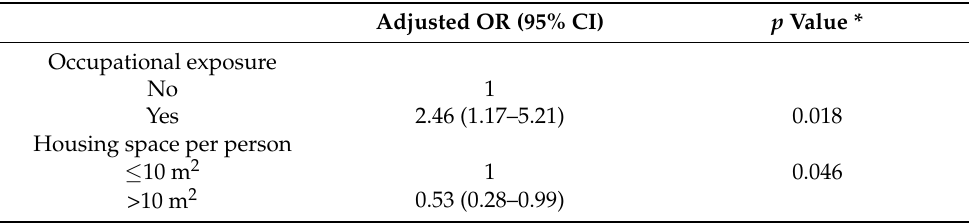
Table 3. The risk of exacerbations after adjusted multivariate analysis for gender and age, of each factor significant on univariate analysis. Only significant adjusted factors are shown below.